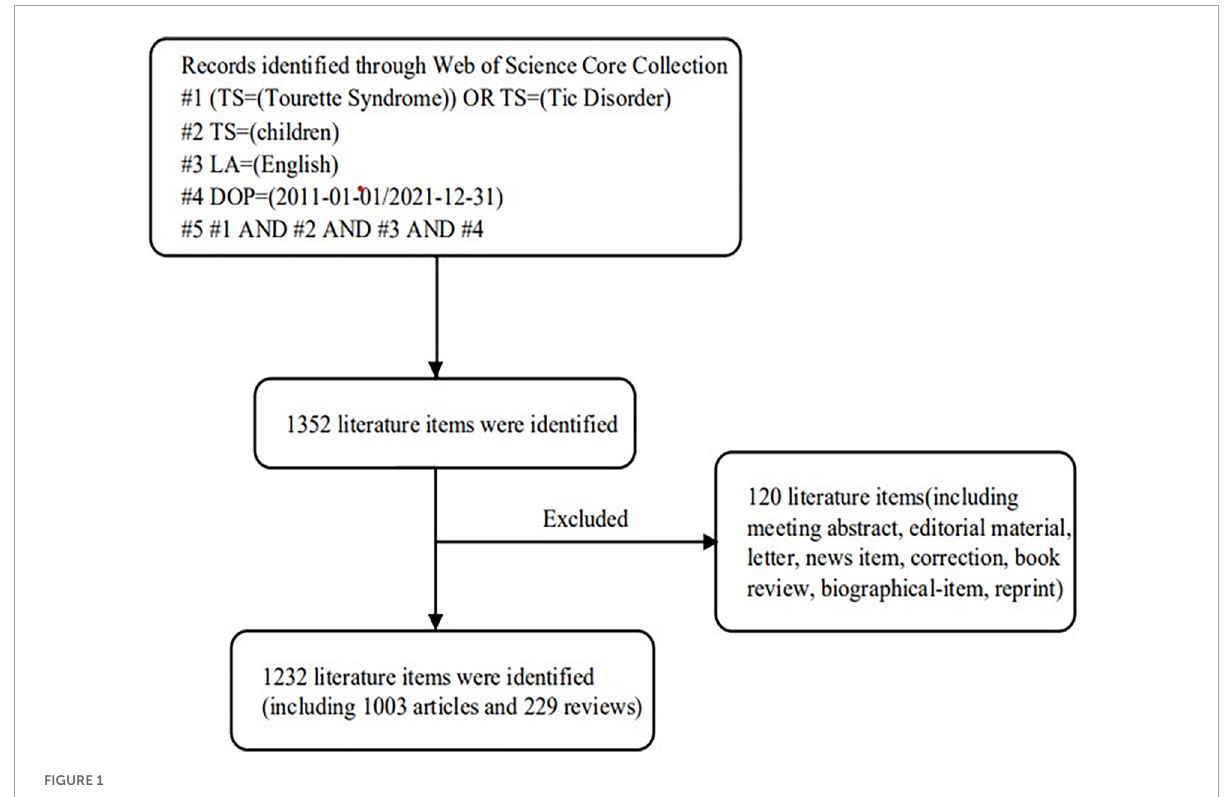
FIGURE1 Frame flow diagram of search strategy.